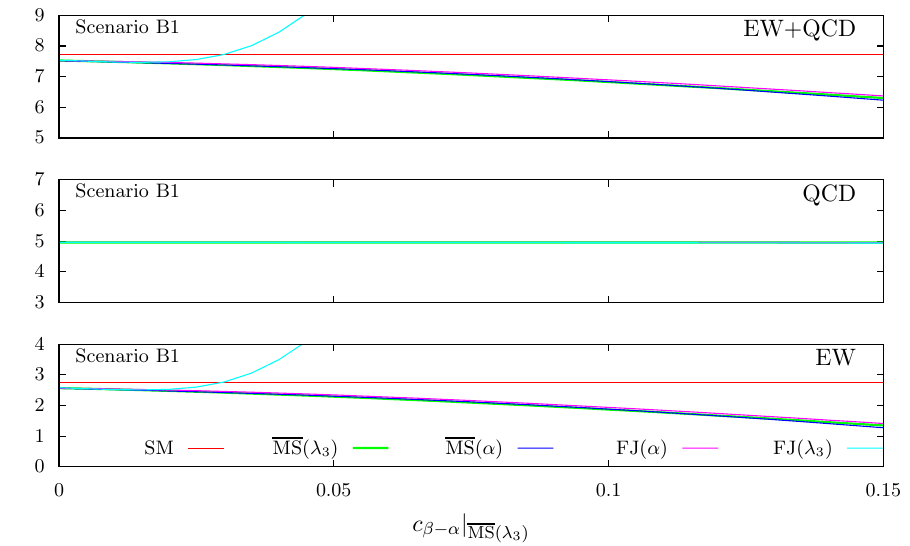
Figure 25 . The relative NLO corrections of the full EW+QCD, the QCD, and the EW calculation in scenario B1. The input is de(cid:12)ned in the MS( (cid:21) 3 ) scheme, and the corrections are computed in all four schemes which are displayed using the colour code of (cid:12)gure 12. For comparison the SM corrections with a SM Higgs-boson mass of M h are shown as well. Note that the results including only the QCD corrections lie on top of each other, and that the green line lies below the blue line for small c (cid:12) (cid:0) (cid:11) and between the pink and the blue line for large c (cid:12) (cid:0) (cid:11) in case of the results including EW and EW+QCD